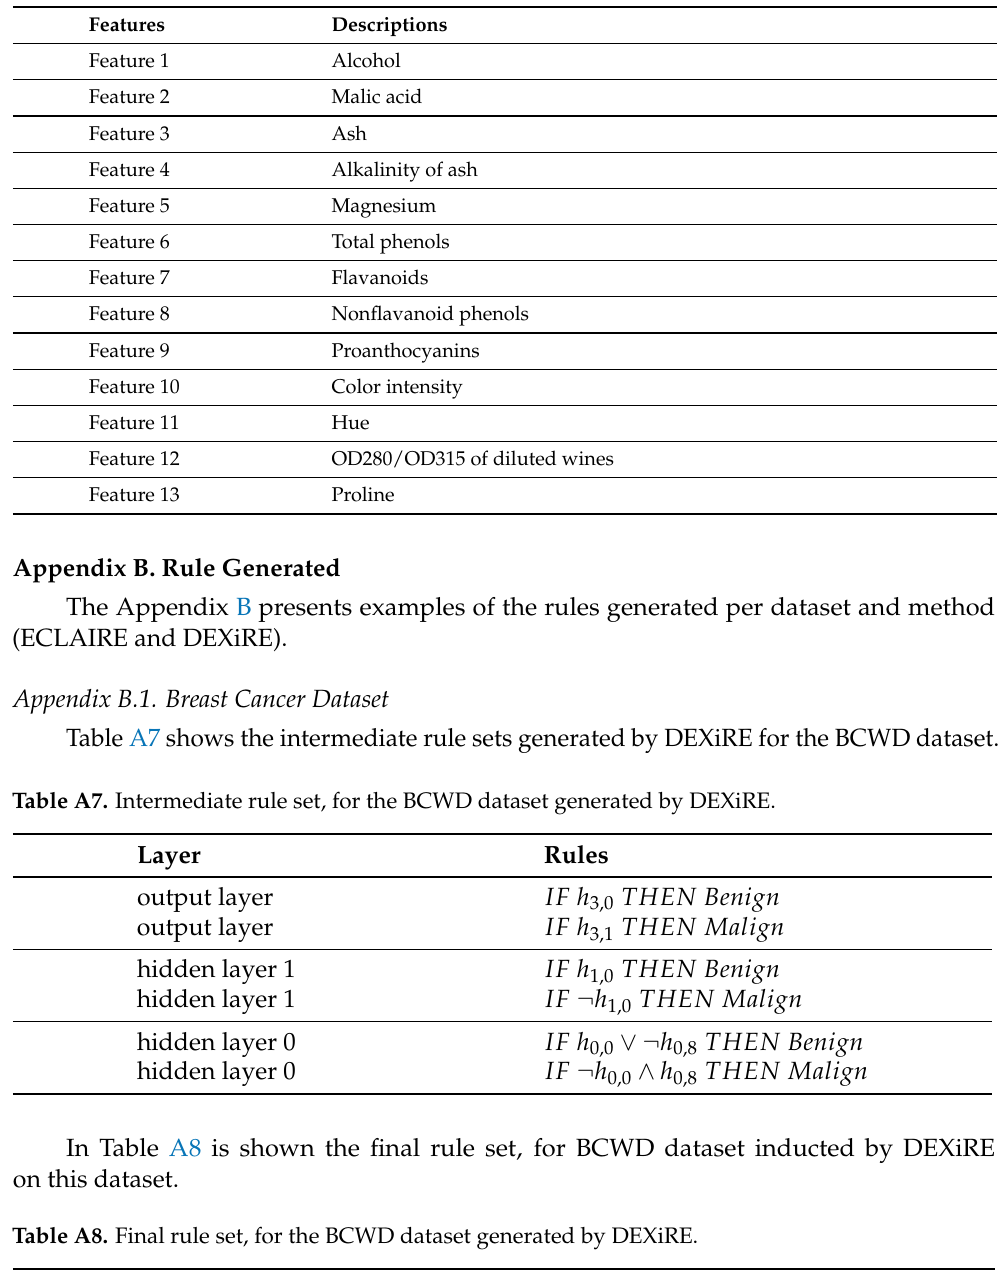
Table A6. Feature description for the wine quality dataset.